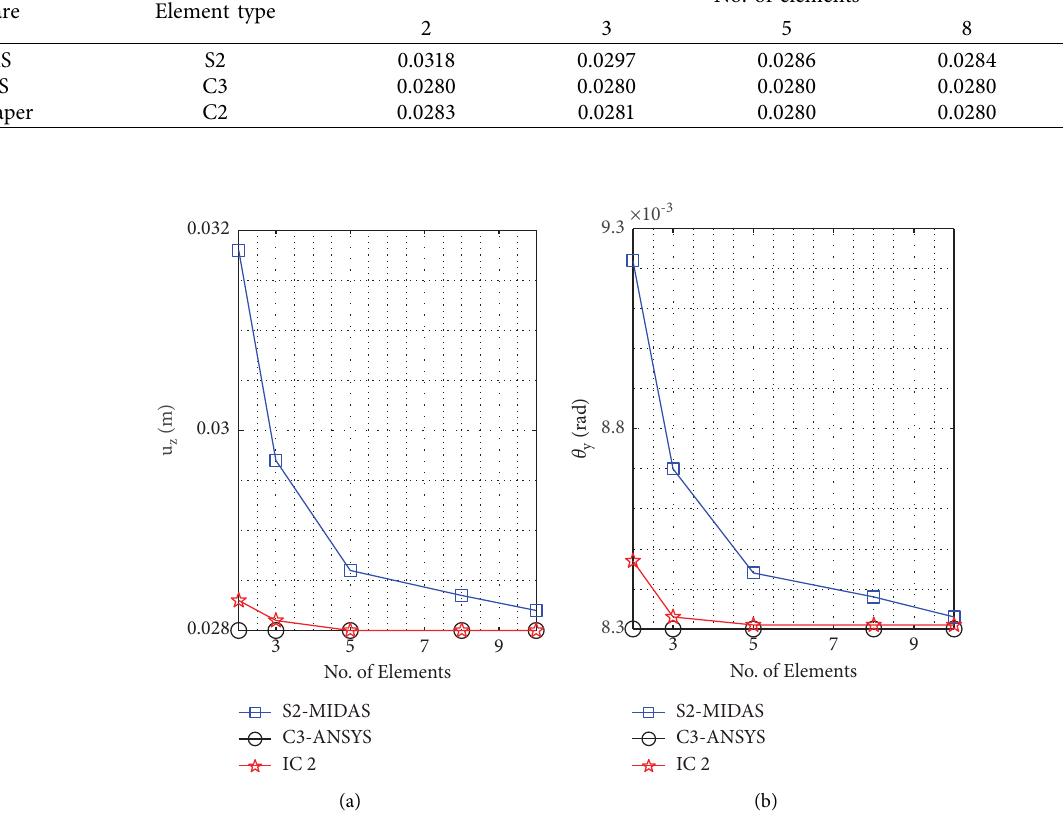
Figure 4: Influences of element types and no. of divisions on the numerical solutions of (a) u